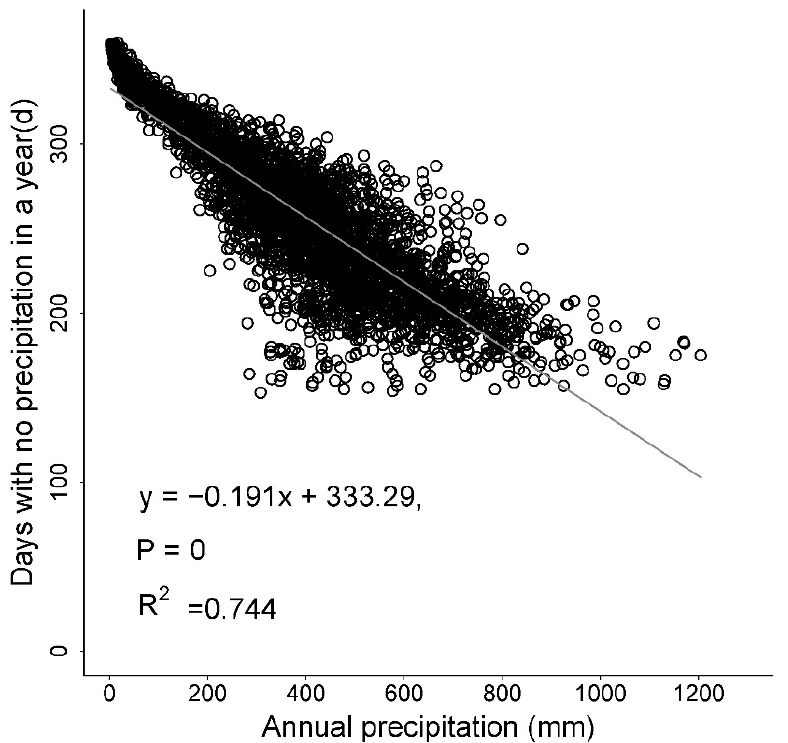
Figure A2. The relationship between annual precipitation and days with no precipitation in a year based on yearly data of 78 meteorological stations from 1960 to 2015 on the QTP.